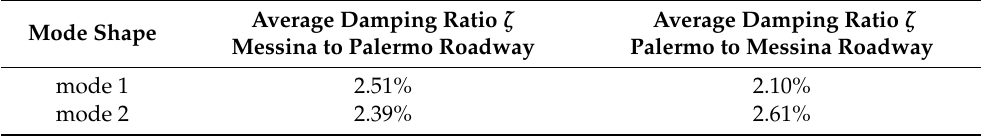
Figure 9. First four mode shapes identified from OMA before static load tests. Table 2. Experimental damping ratios (average values) for the first two modes of